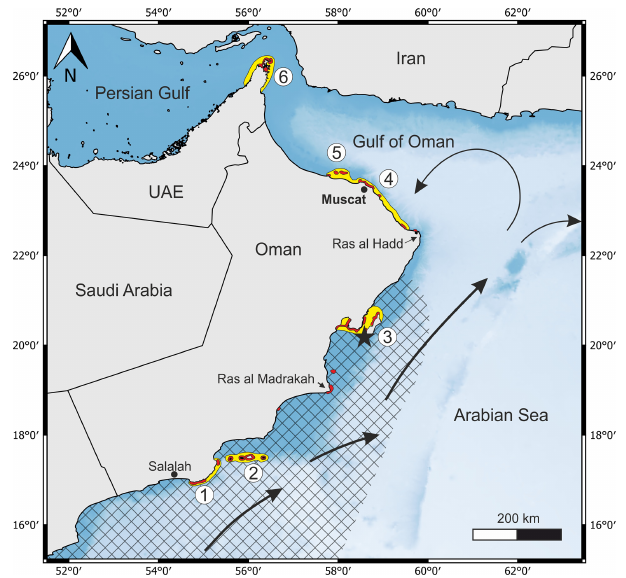
Figure 1. General map of the eastern Arabian Peninsula and the adjacent seas showing the reef sites (red) and coral reef provinces off Oman (yellow) (1 Marbat, 2 Kuria Muria Islands, 3 Masirah Island and Barr al Hikman, 4 capital area, 5 Daymaniyat Islands, and 6 Musandam; Salm, 1993; Burt et al., 2016). The black asterisk marks the sampling site at the southern tip of Masirah Island. Black arrows indicate the Omani current during the southwest monsoon. The hatched area delimitates the region of maximum upwelling inferred from August sea surface temperatures < 25 ◦ C (1995– 2005 monthly averages; WOA18, Locarnini et al., 2018). The blue shading displays water depth gradients (dark blue = shallow, light blue =